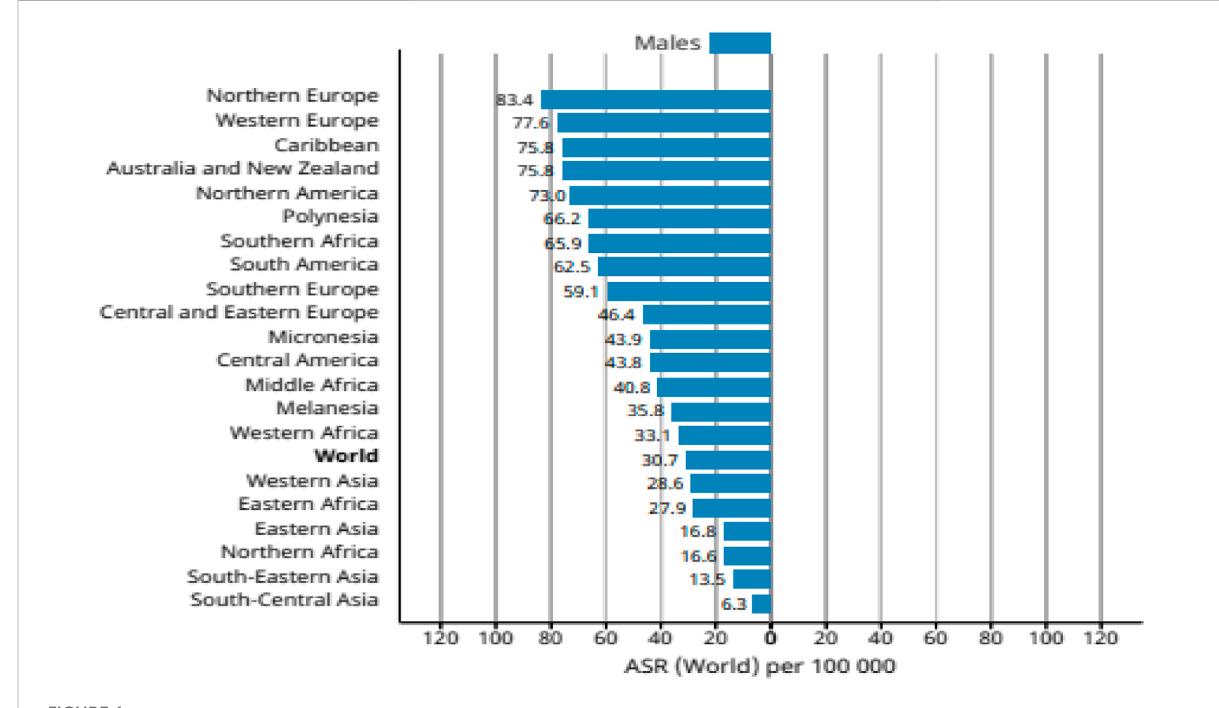
FIGURE 1 Association of obesity with different types of cancers.